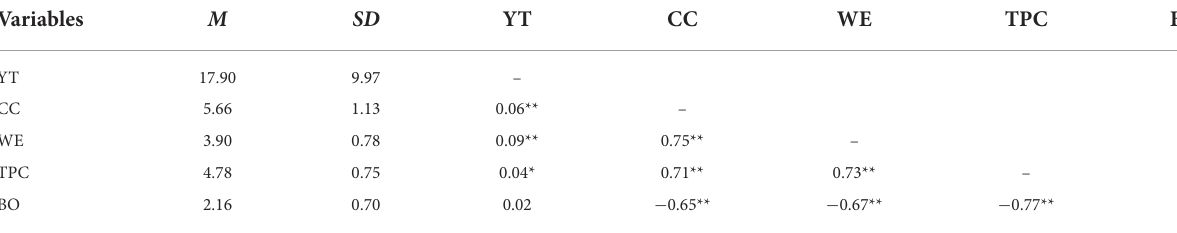
TABLE 1 Means, standard deviations, and Pearson’s correlations among variables.